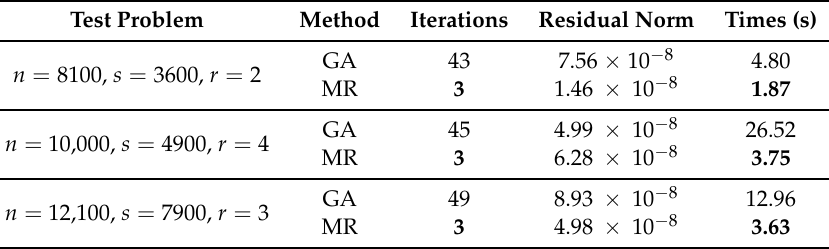
Table 1. Results for Example 1.